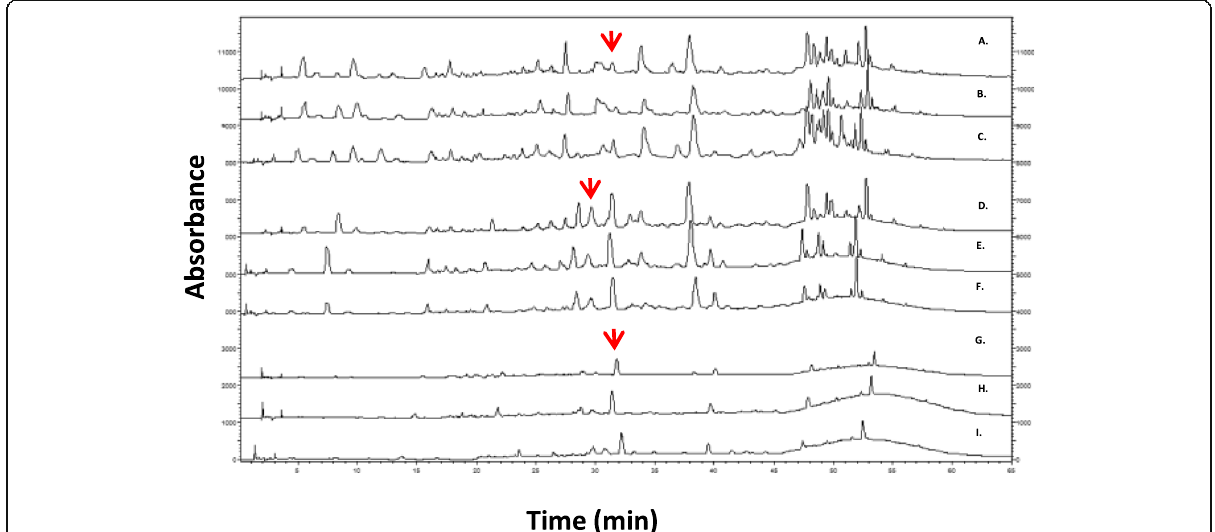
Fig. 8 A representative RP-LC chromatograms of different extracts prepared from different plants. Leaves (A-C chromatograms), fruits